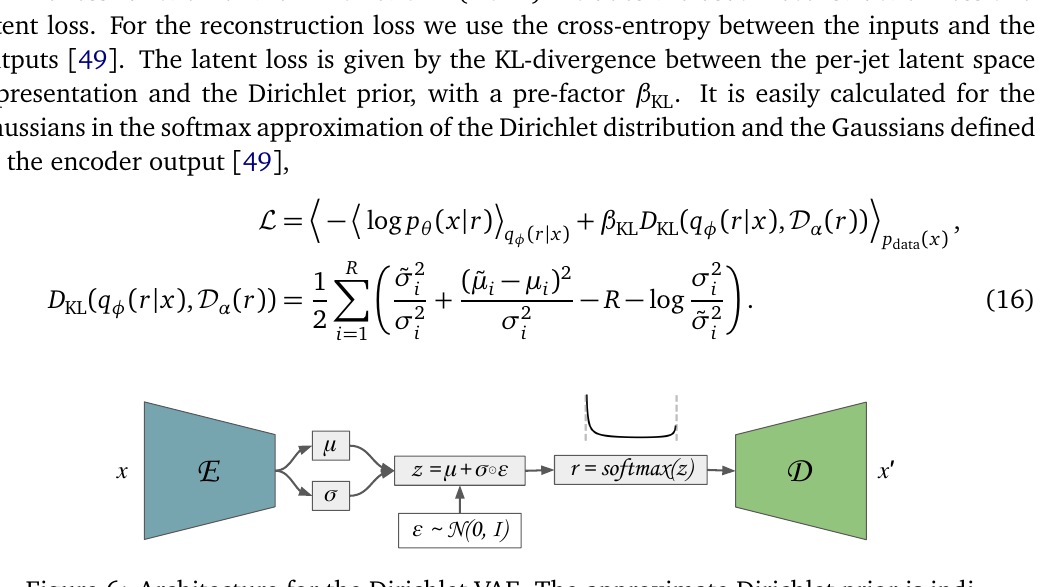
Figure 6: Architecture for the Dirichlet VAE. The approximate Dirichlet prior is indi- cated by the softmax step and the bi-modal distribution shown above